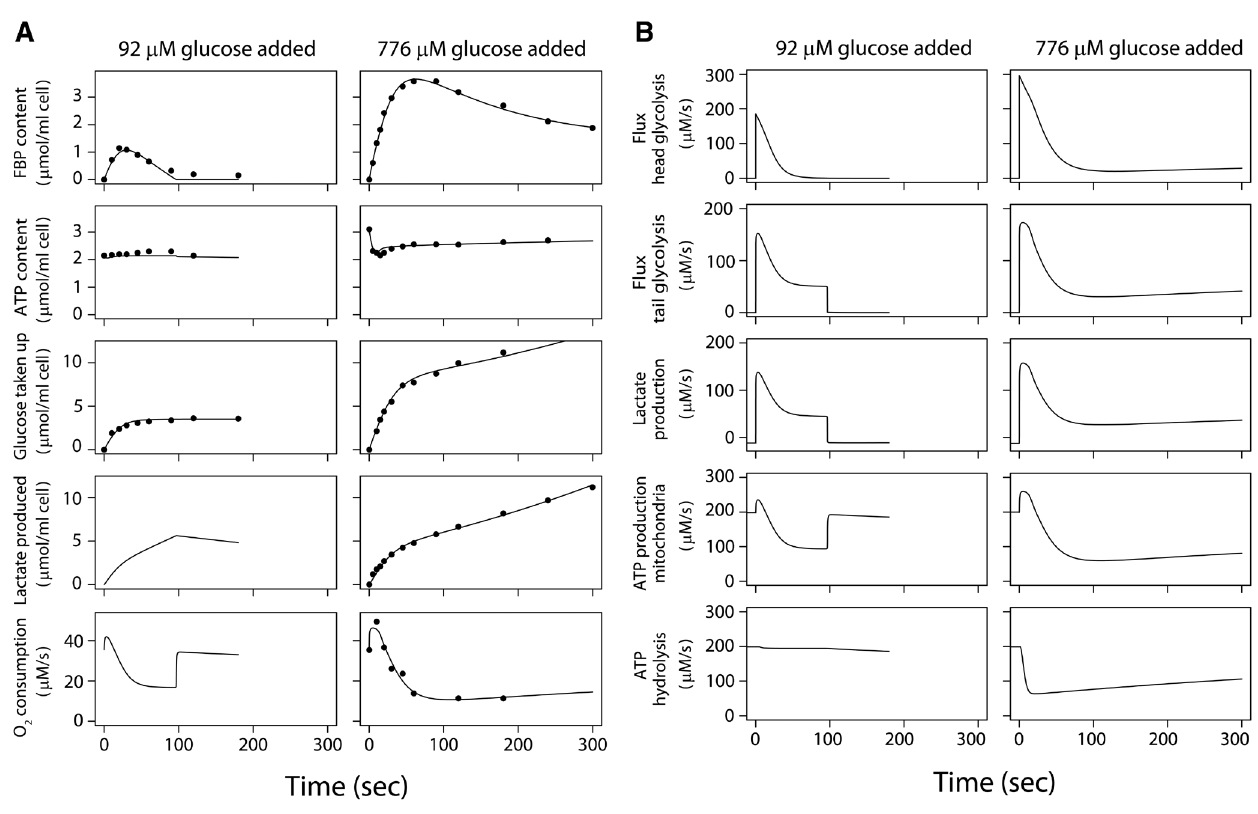
Figure 2. Response of Ehrlich ascites tumor cells in vitro to addition of different amounts of glucose. ( A ) Glucose concentration was zero at t<0, and the cells respired on endogenous substrates, such as lactate. Glucose was added at t=0. Data for experiments (dots) and model fit (lines). Left hand column: low initial glucose concentration (92 µM) was added at t=0 to a suspension of 2.2 volume percent tumor cells. Right hand column: a higher glucose concentration (776 µM) was added at t=0 to a suspension of 2.9 volume percent tumor cells. Contents of fructose 1,6-bisphosphate (FBP), ATP, total glucose taken up and total lactate produced since t=0 are given in µmol/ml cell volume. The rate of O consumption is given in µmol/liter intracellular water/sec. ( B ) Response of 2 metabolic fluxes in Ehrlich ascites tumor cells in vitro to addition of different amounts of glucose. Same simulation as in Figure 2A. The fluxes are given in µmol/liter intracellular water/sec (µM/s). The fluxes shown here result in the changes in metabolite concentrations, oxygen consumption, glucose uptake and lactate production seen in Figure 2A. The flux in the glycolytic head section is given in 6-carbon units and the flux in the tail section in 3-carbon units. The tail section of glycolysis synthesizes 2 ATP per 3-carbon unit. Note that for t<0 lactate is taken up and used for mitochondrial ATP production in the absence of